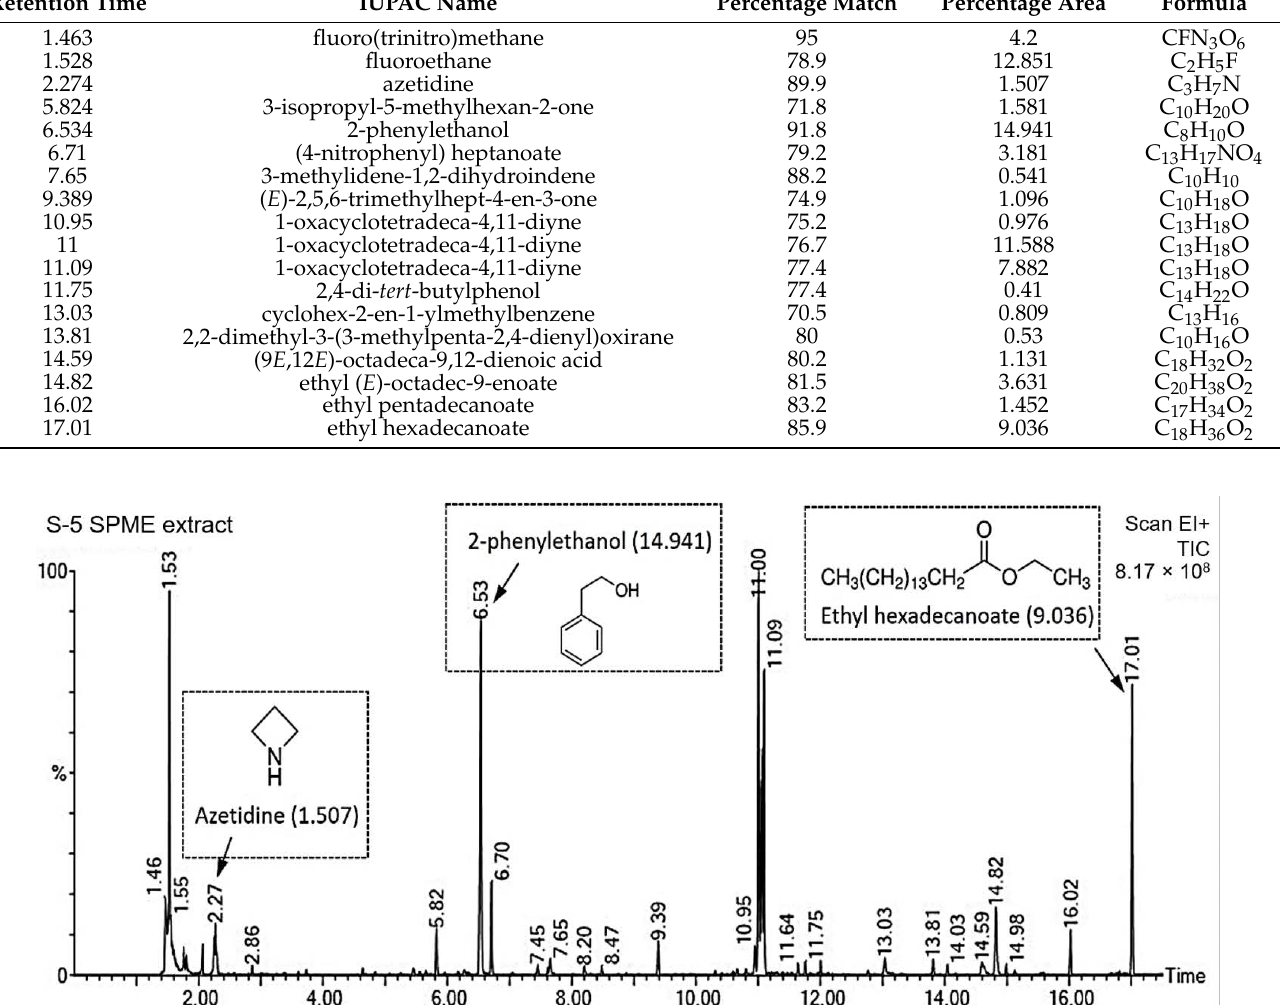
Figure 2. Total ion chromatogram of volatile compounds identified from T. koningiopsis PSU3-2 through GC/MS analysis. Peaks at 2.27, 6.53, and 17.01 min were tentatively identified as azetidine, 2-phenylethanol, and ethyl hexadecanoate, the structures of which are shown. Numbers in parentheses indicate the percentage of peak